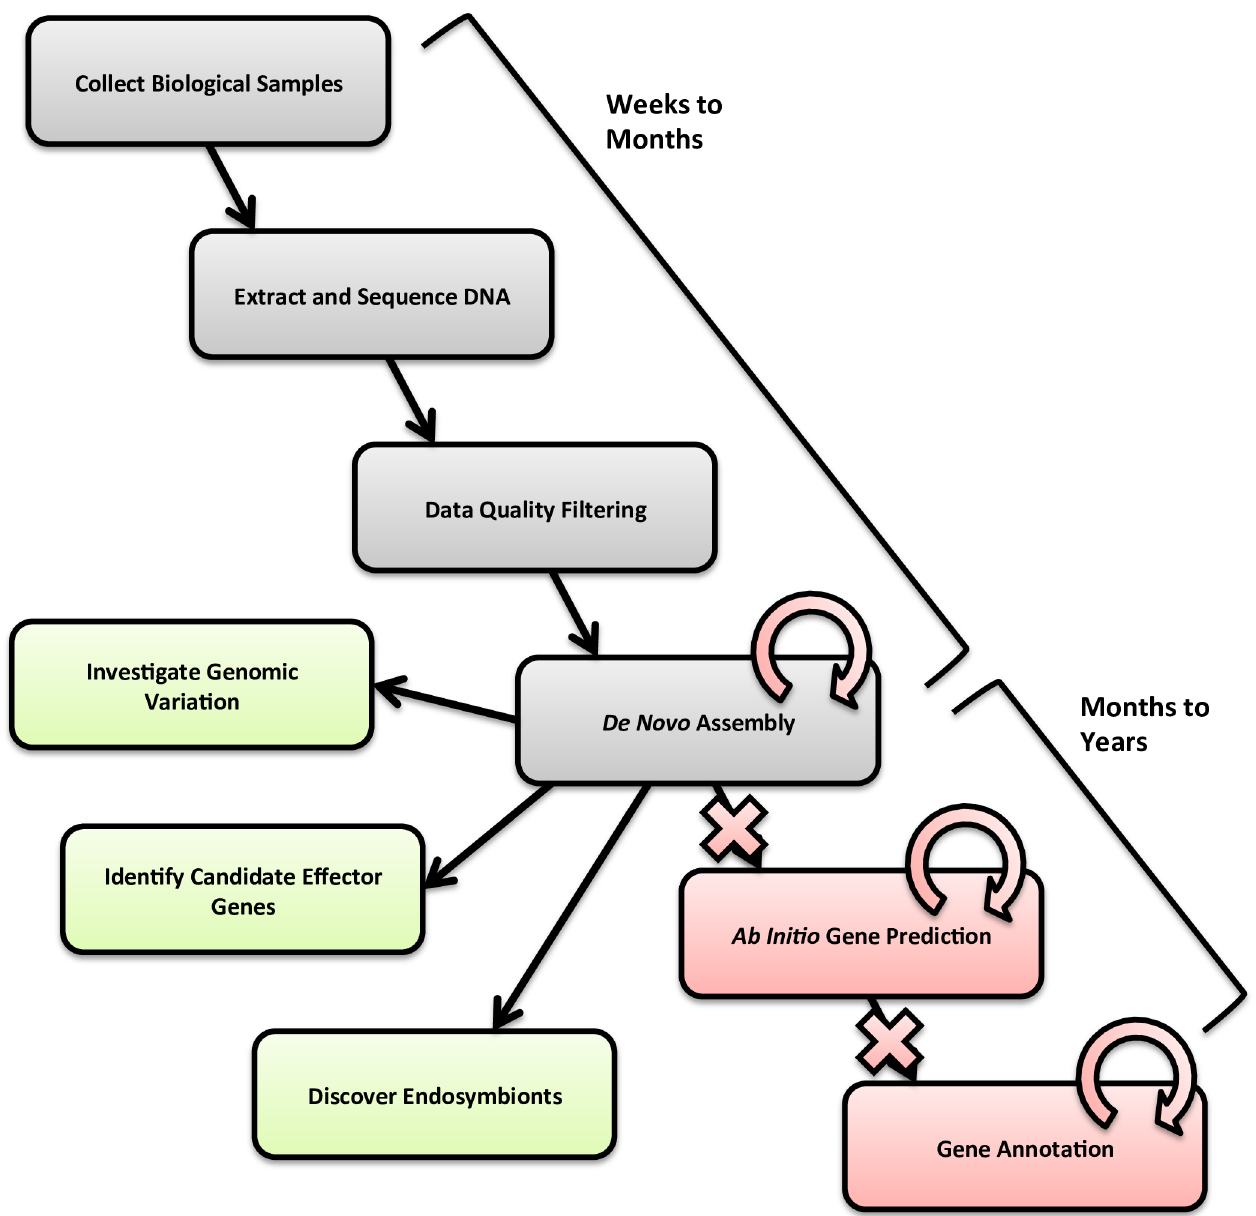
Fig 1. Genome skimming schematic. Boxes progressing diagonally from top left to bottom right show steps typical of conventional genome projects. Grey boxes show steps shared by genome skimming and conventional genome projects. Red boxes, arrows, and Xs show conventional genome project steps eliminated in the genome skimming approach. Green boxes show analyses specific to our genome skimming